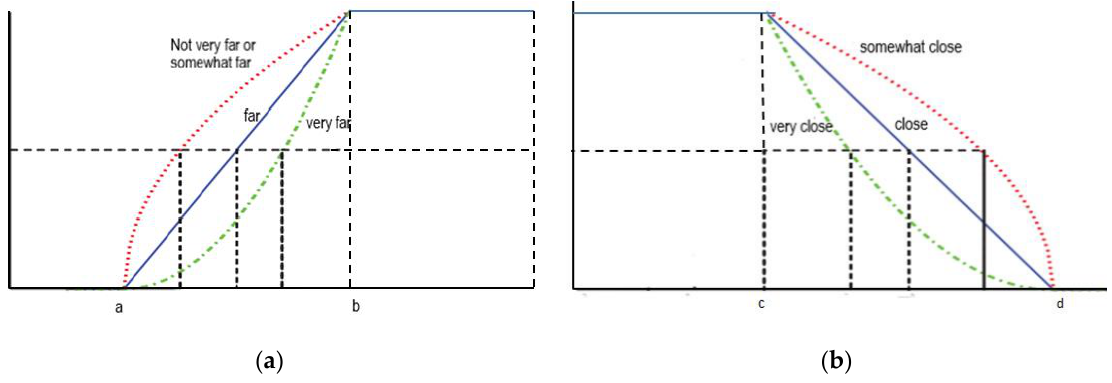
Figure 2. Reinforcing and weakening modifiers in fuzzy hedges (Source: [40]).